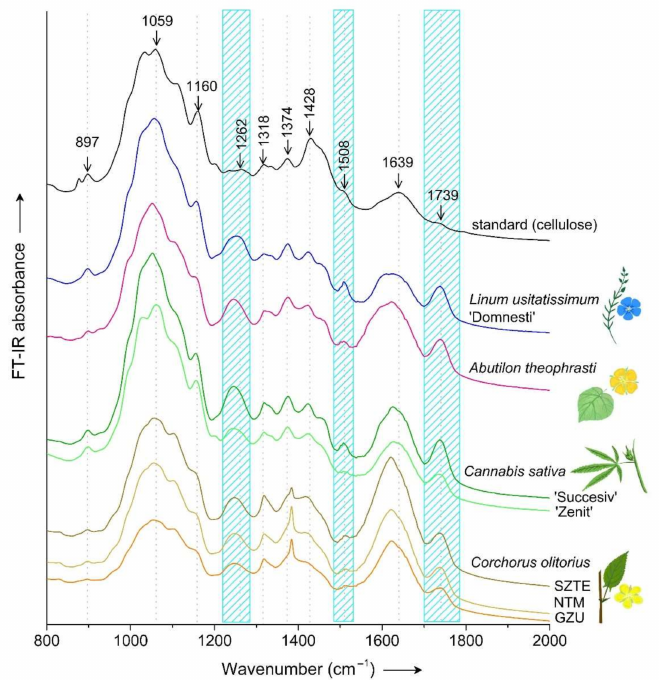
Figure 5. Detail of FT-IR spectral region 800–2000 cm − 1 for stems of flax, velvet leaf, hemp and jute compared to cellulose; cyan strips mark regions of high variability compared to